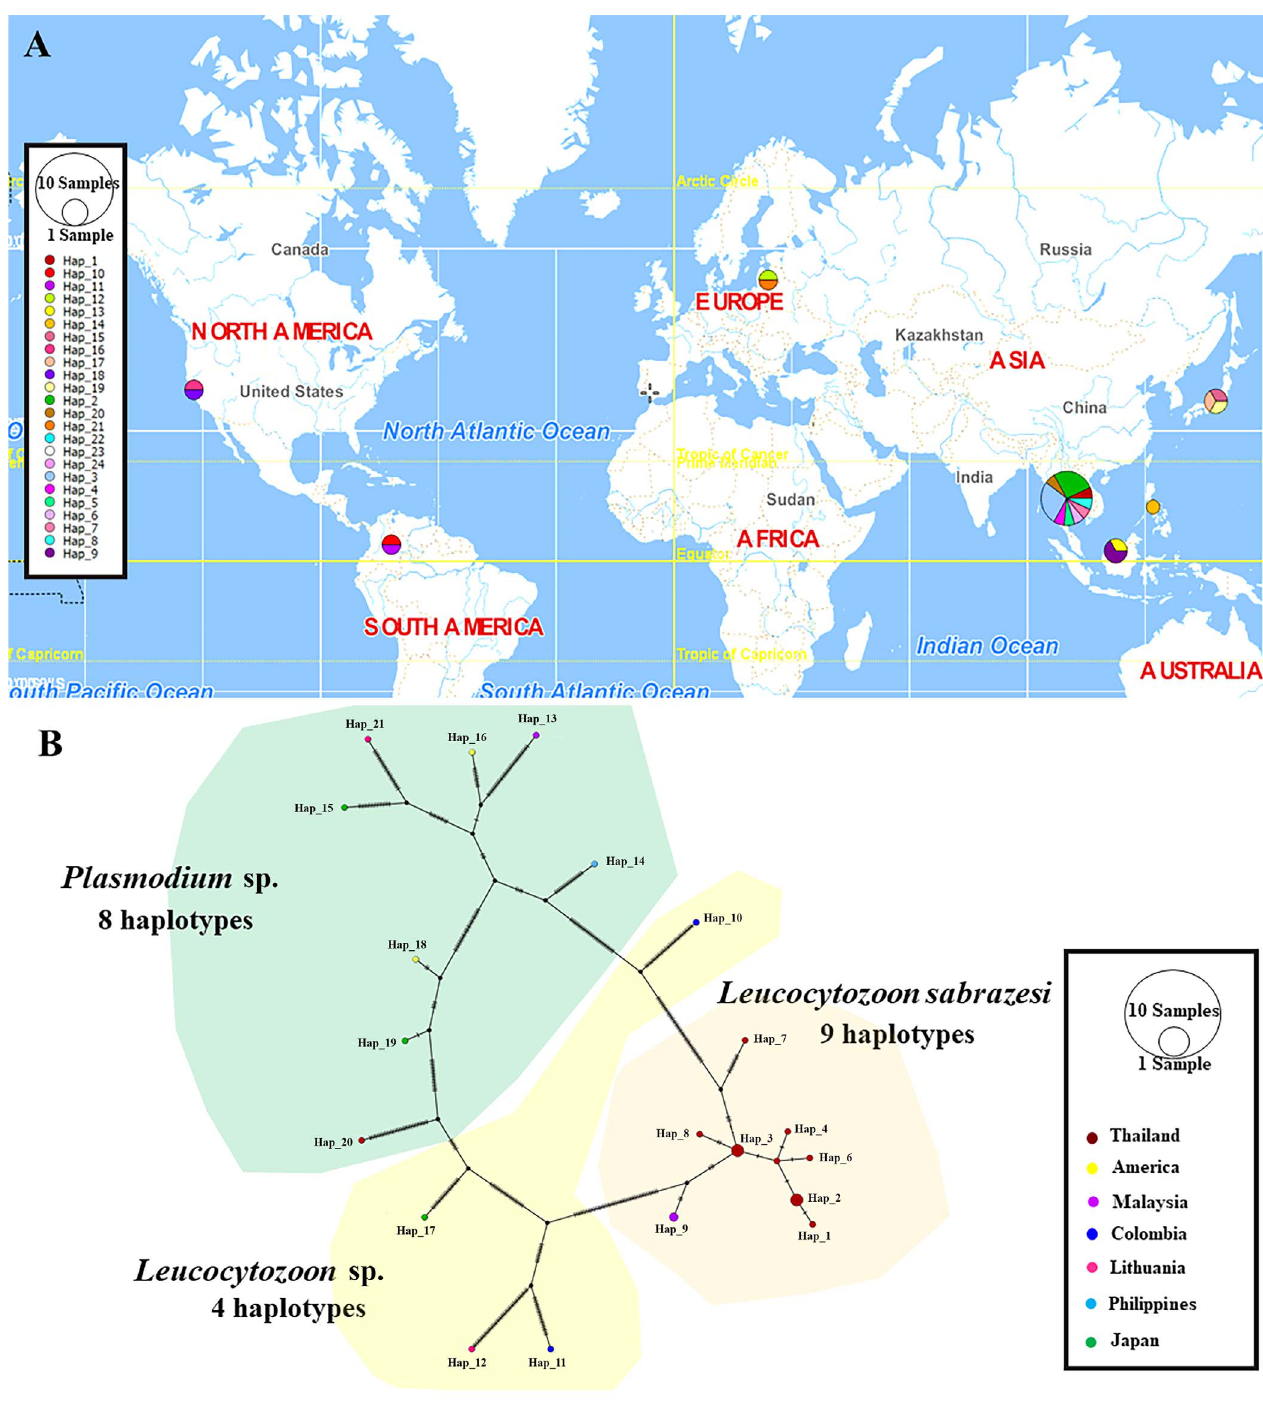
Fig. 10. TCS network of haplotypes based on Leucocytozoon spp. and Plasmodium spp. concatenated gene sequences (A) detected in Thailand and other countries. The number of bars on lines between a haplotype and another represent the number of nucleotide mutation